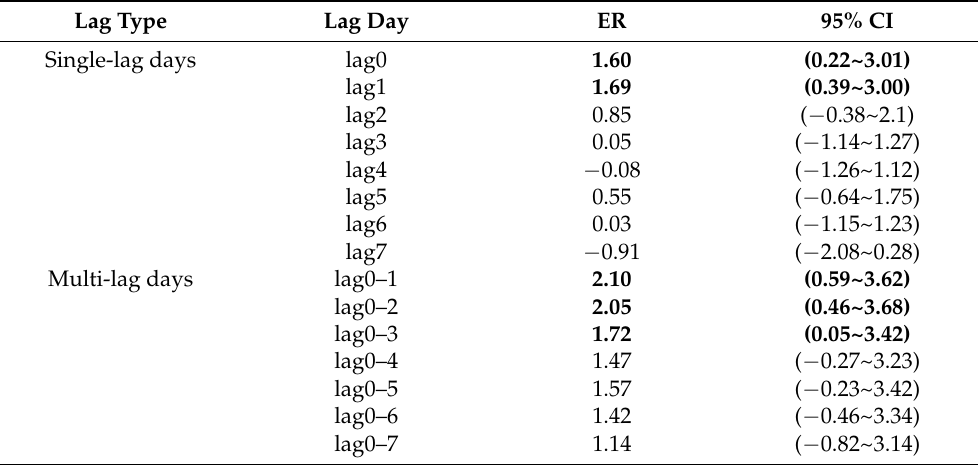
Table 2. Effects of different lag days on CHD hospitalization risk in a single pollutant model (ER% (95%CI) for 10 µ g/m 3 increment of PM 10 ).